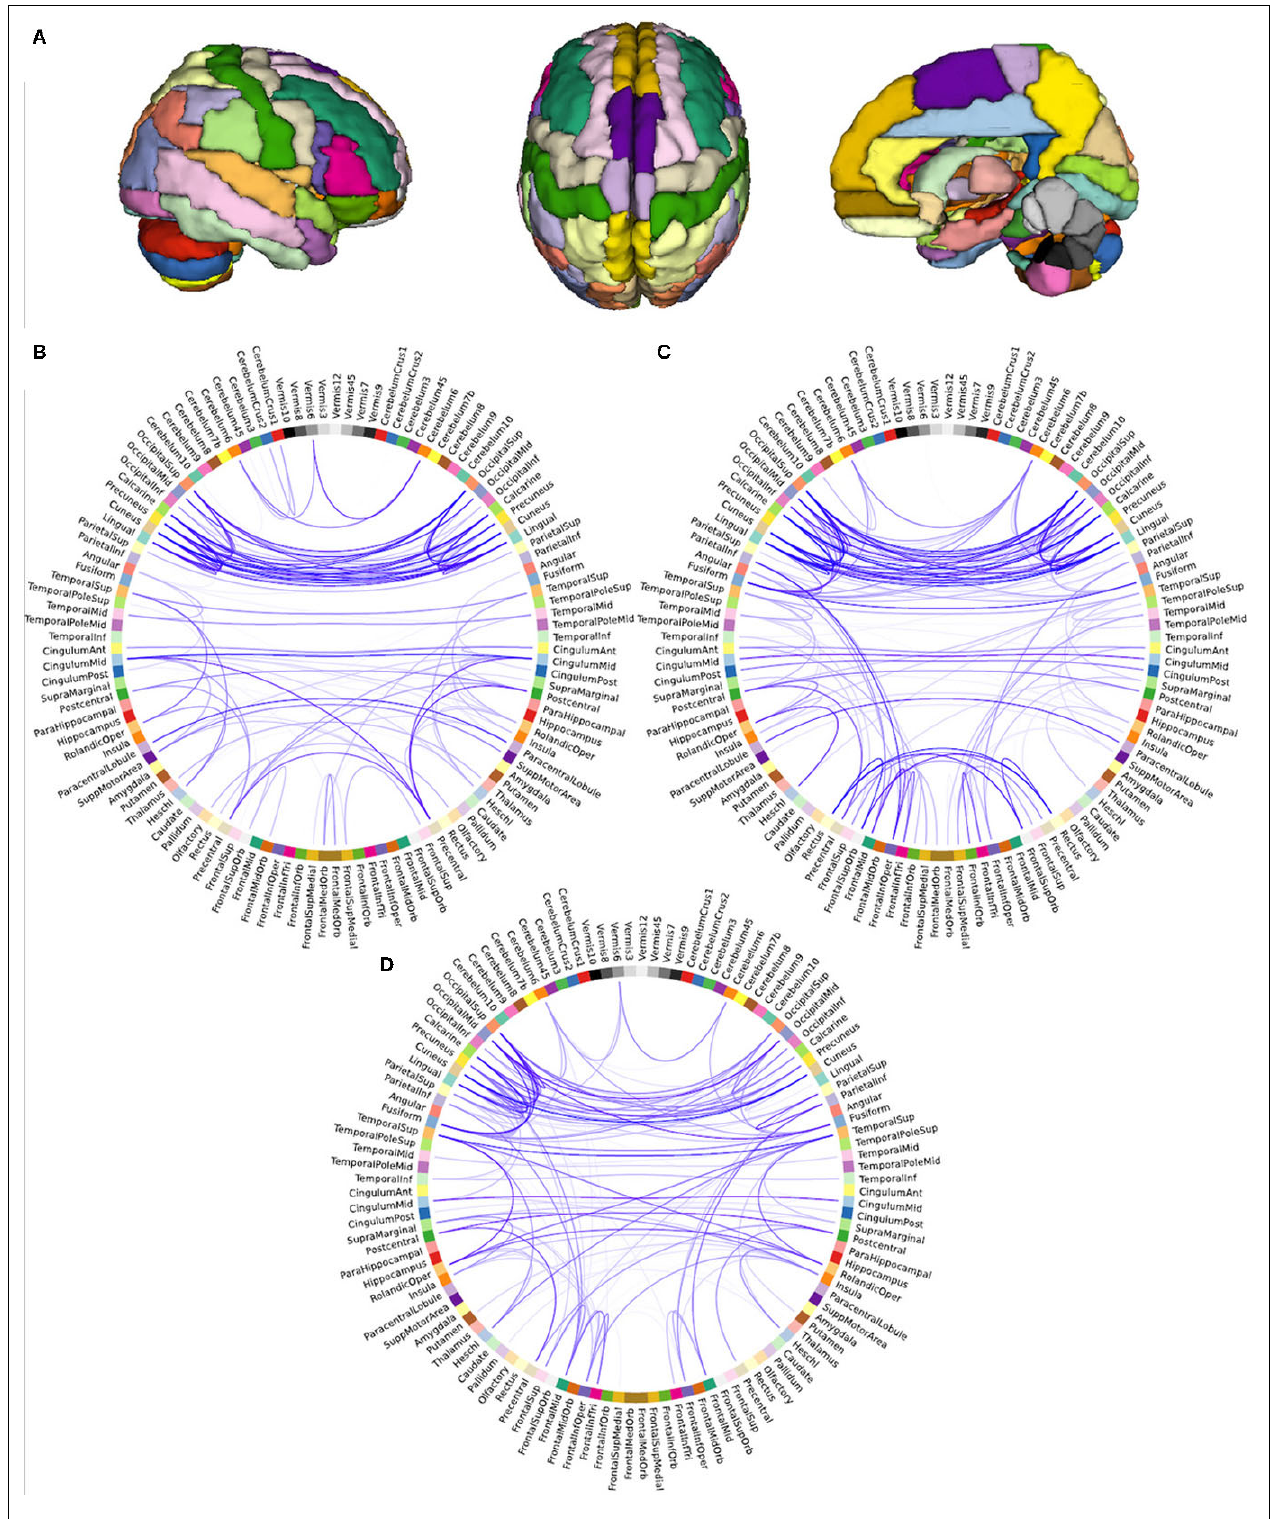
FIGURE 2 | Visualization of network creation. Parcellation of brain into 116 regions (A) , and structure of weighted resting state functional networks of a representative control (B) , yoga practitioner (C) , and meditator (D) . Networks